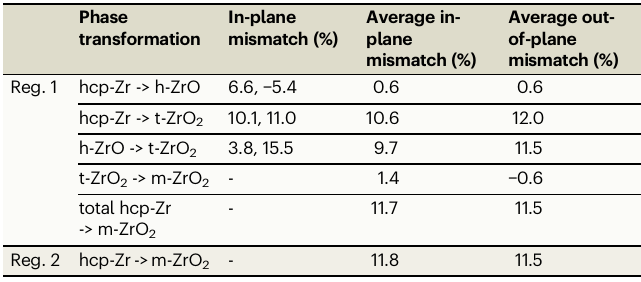
Table 1 | Epitaxial mismatch between different Zr and oxide phases Phase transformation